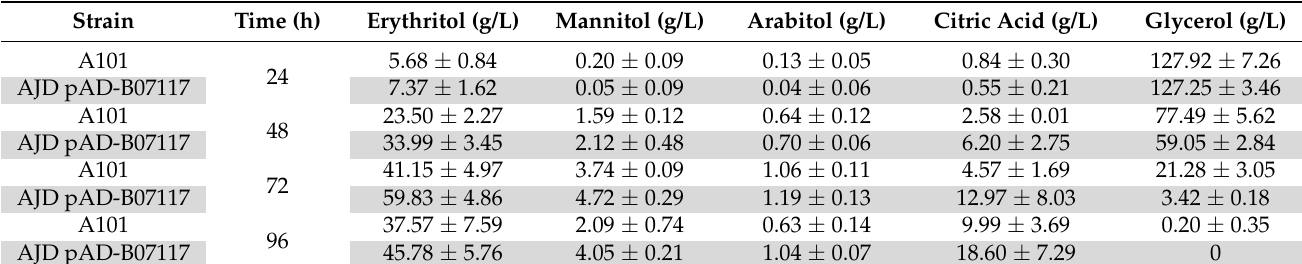
Table 2. Erythritol and byproduct synthesis of Y. lipolytica strains in bioreactor experiments. Strain Time (h) Erythritol